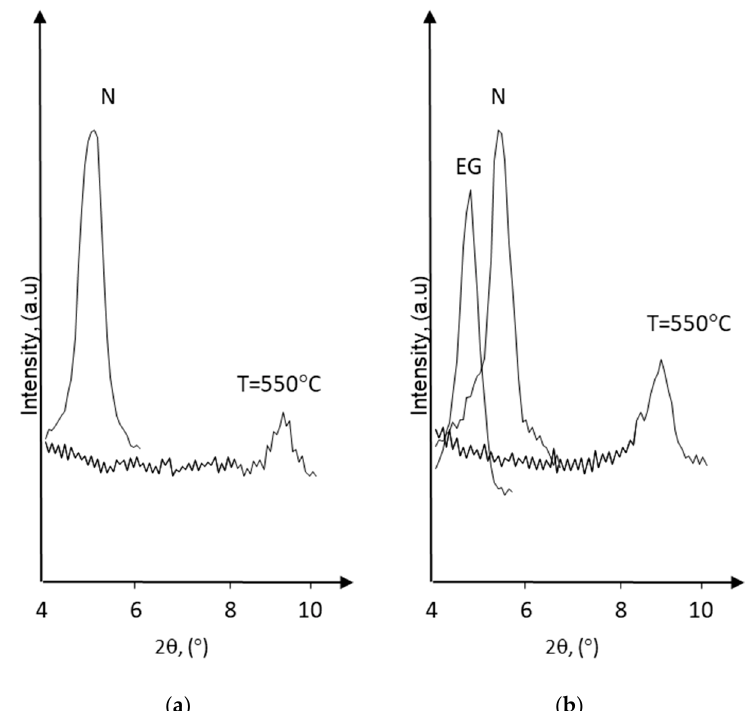
Figure 6. XRD patterns of the bentonite from Ora ş ul Nou: ( a ) comparison of the bulk (N) and calcinated sample, ( b ) oriented and ethylene glycol saturated (EG) sample compared to bulk (N) and calcinated samples.